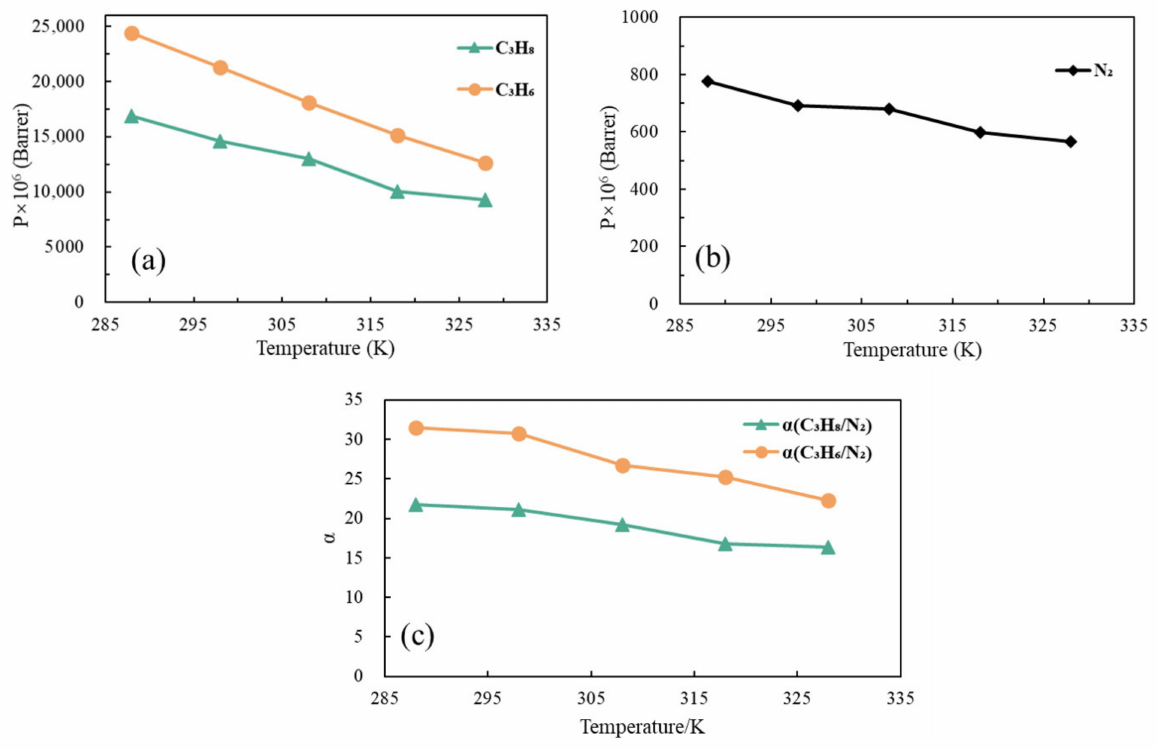
Figure 10. Permeability coefficients of ( a ) C 3 and ( b ) N 2 , and ( c ) the selectivity coefficient of N 2 , C 3 H 8 and C 3 H 6 at different